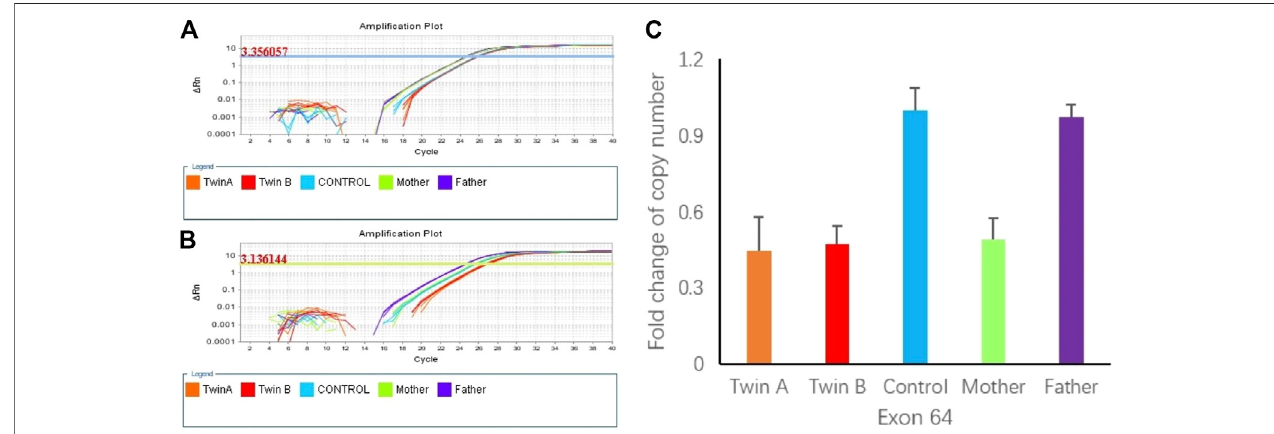
FIGURE 3 | (A) Ampli fi cation plot of β -actin (3.350657 represent the fl ourescence thresholds value of beta-actin). (B) Ampli fi cation plot of DNAH11 exon 64 (3.1366144representthe fl ourescencethresoldsvalueoftargetgene). (C) Copynumbersofexon64ofDNAH11con fi rmedbyqPCRusinggenomicDNAfromthetwins and the parents.